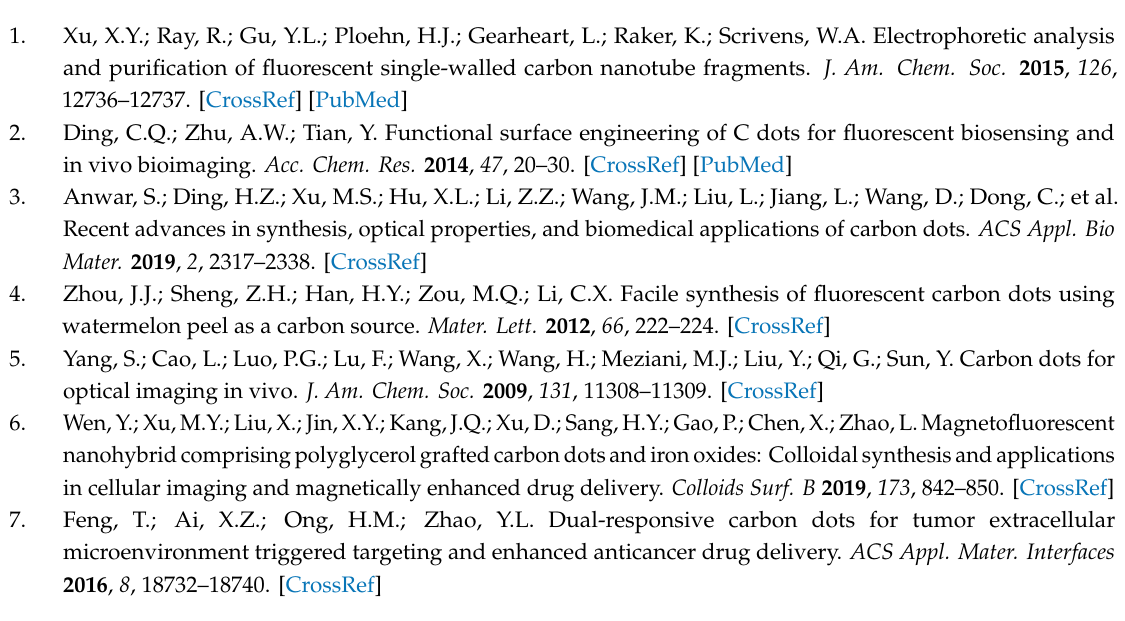
Figure S1: The XRD ( a ) and Raman spectra ( b ) of PCDs, Figure S2: The photoluminescent decay profiles and lifetimes of PCDs and PCDs-Eu 3 + , Figure S3: The variation of fluorescence intensity for PCDs with irradiation time ( λ ex / λ em = 375 / 645 nm), Figure S4: Cell viability of HeLa cells at di ff erent concentrations of PCDs ( a ); Confocal fluorescence microscopy images of HeLa cells without labeling under bright field ( b ) and the excitation wavelength of 552 nm ( c ), Figure S5: TEM images of PCDs-Eu 3 + ( a ) and PCDs-Eu 3 + -PO 43 − ( b ), Figure S6: The relationship between F 0 / F-1 and the concentration of Eu 3 + , Figure S7: Fluorescence variations of PCDs-Eu 3 + to di ff erent kinds of anions and cations, Figure S8: The emission spectra of PCDs-Eu 3 + upon the addition of various amounts of phosphate (0.1–60.0 µ mol · L − 1 ); Inset: the photographs of PCDs-Eu 3 + in the presence of 0, 4, 10, 20, 40, 60 µ mol · L − 1 phosphate and the original PCDs(from left to right) under the illumination of daylight and UV light, Figure S9: Fluorescence response of PCDs-Eu 3 + -PO 43 − under the co-existing of other ions (PO 43 − , 50 µ mol L − 1 ; Br − , SO 32 − , S 2 − , ClO − , NO 3 − , HCO 3 − , Cl − , AC − , SO 42 − , K + , Na + , CO 32 − , I − , 5000 µ mol L − 1 ; F − , Zn 2 + , Mg 2 + , Fe 2 + , Fe 3 + , Ba 2 + , Ca 2 + , Cu 2 + , Cd 2 + , 300 µ mol L − 1